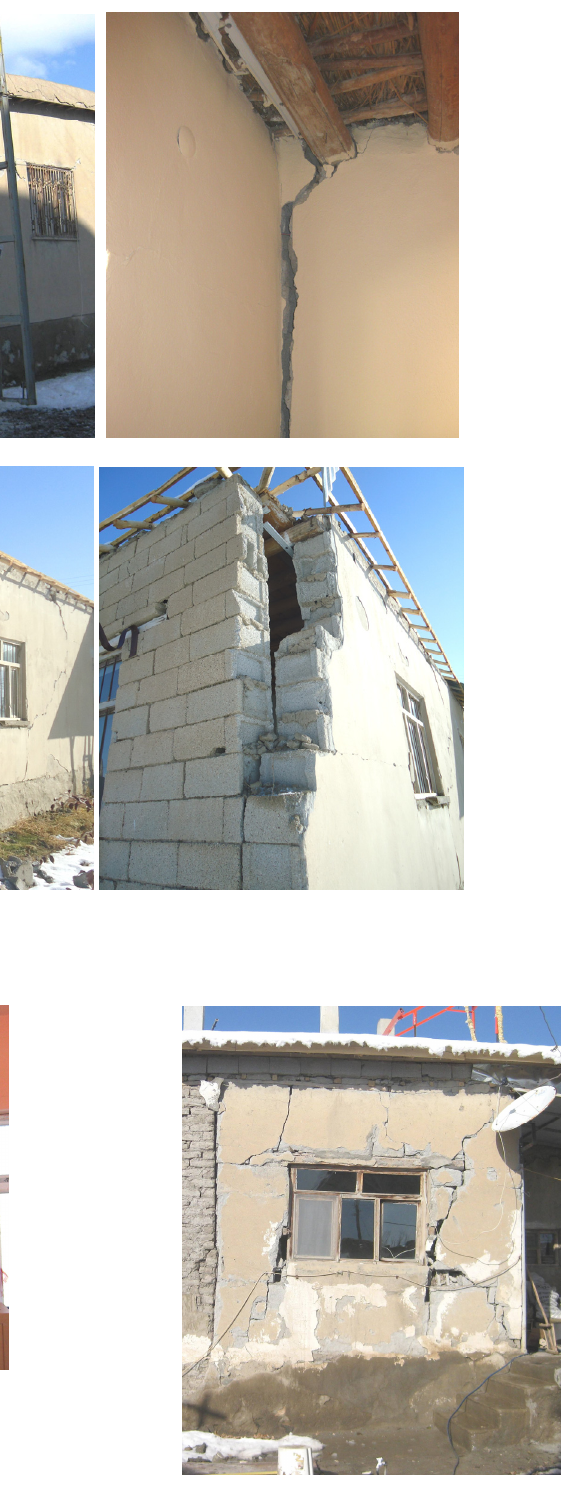
Fig. 11. Damage concentrated around wall opening near the building corner.